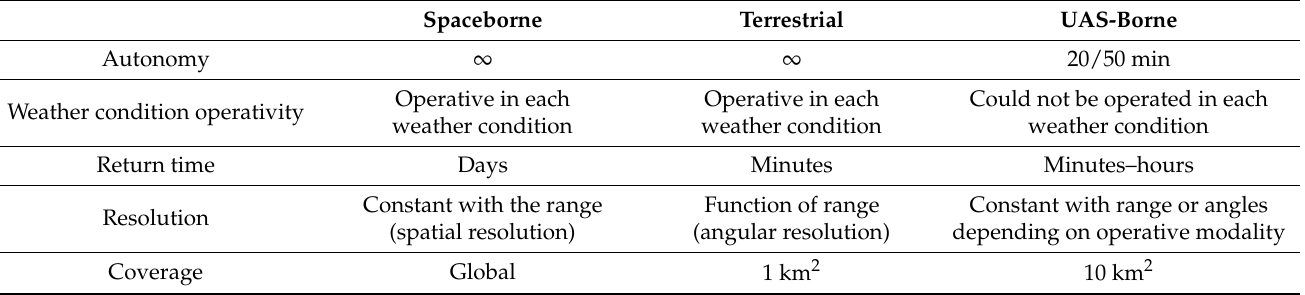
Table 1. EASA pilot certificate’s category, limitations, and UAS